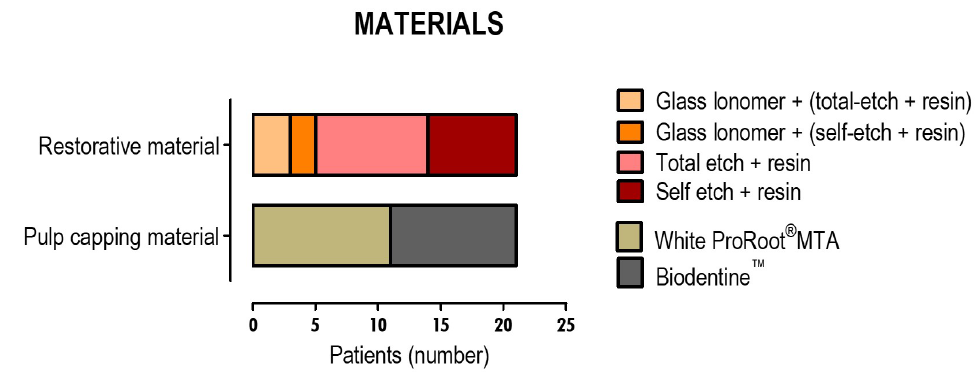
Figure 2. Types of material used for the direct pulp capping and restoration of the dental structure. The results are for 21 teeth, in which pulp capping therapies were performed.